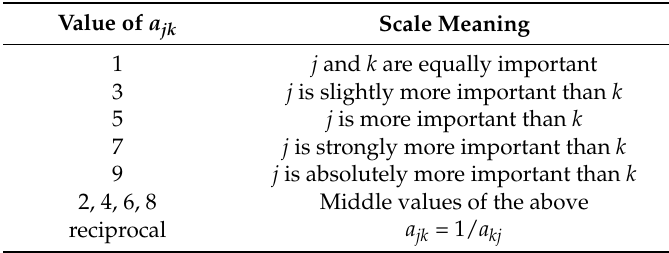
Table 3. Table of relative scores.